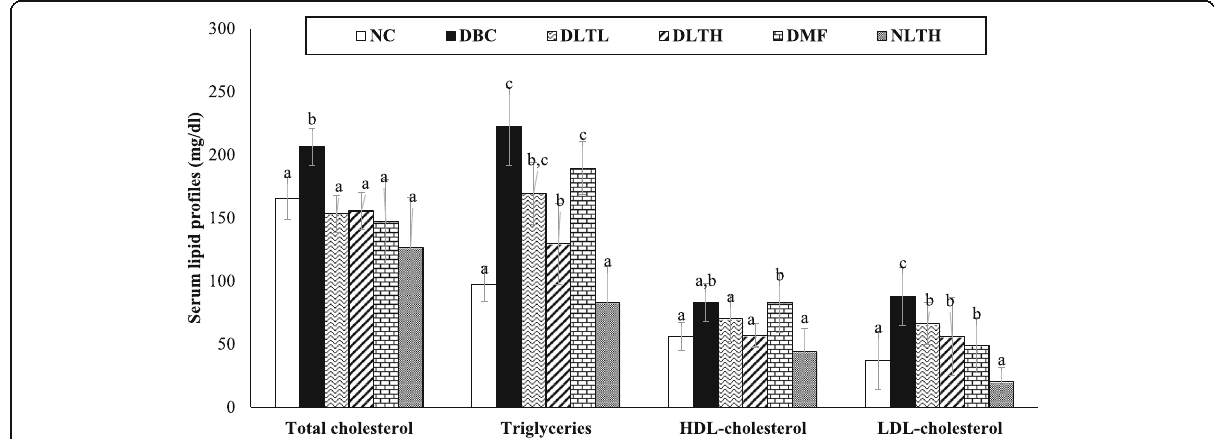
Fig. 5 Lipid profile levels of different animal groups during the experimental period. Data are presented as the mean ± SD of 7 animals. a – c Values with different letters over the bars for a given parameter are significantly different from each other group of animals (Tukey ’ s-HSD multiple range post hoc test, p < 0.05). NC- Normal control; DBC- Diabetic control; DLTL- Diabetic lemongrass tea low; DLTH- Diabetic lemongrass tea high;